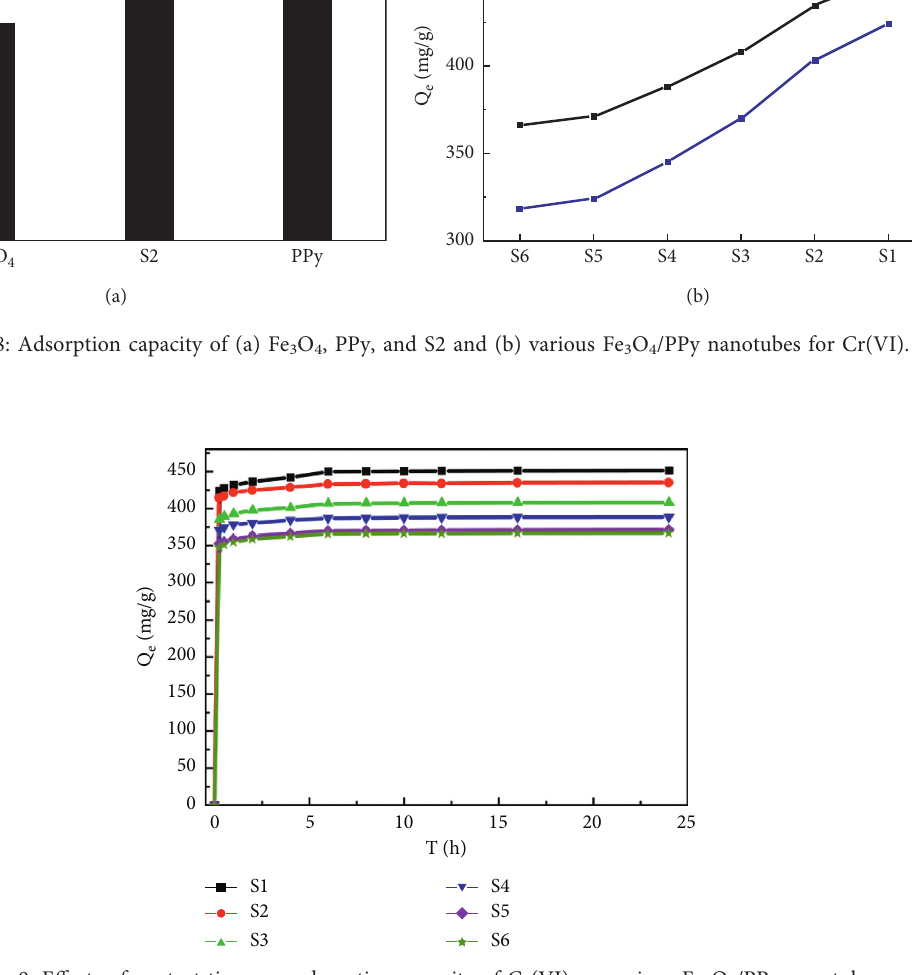
3 O 4 /PPy nanotubes.